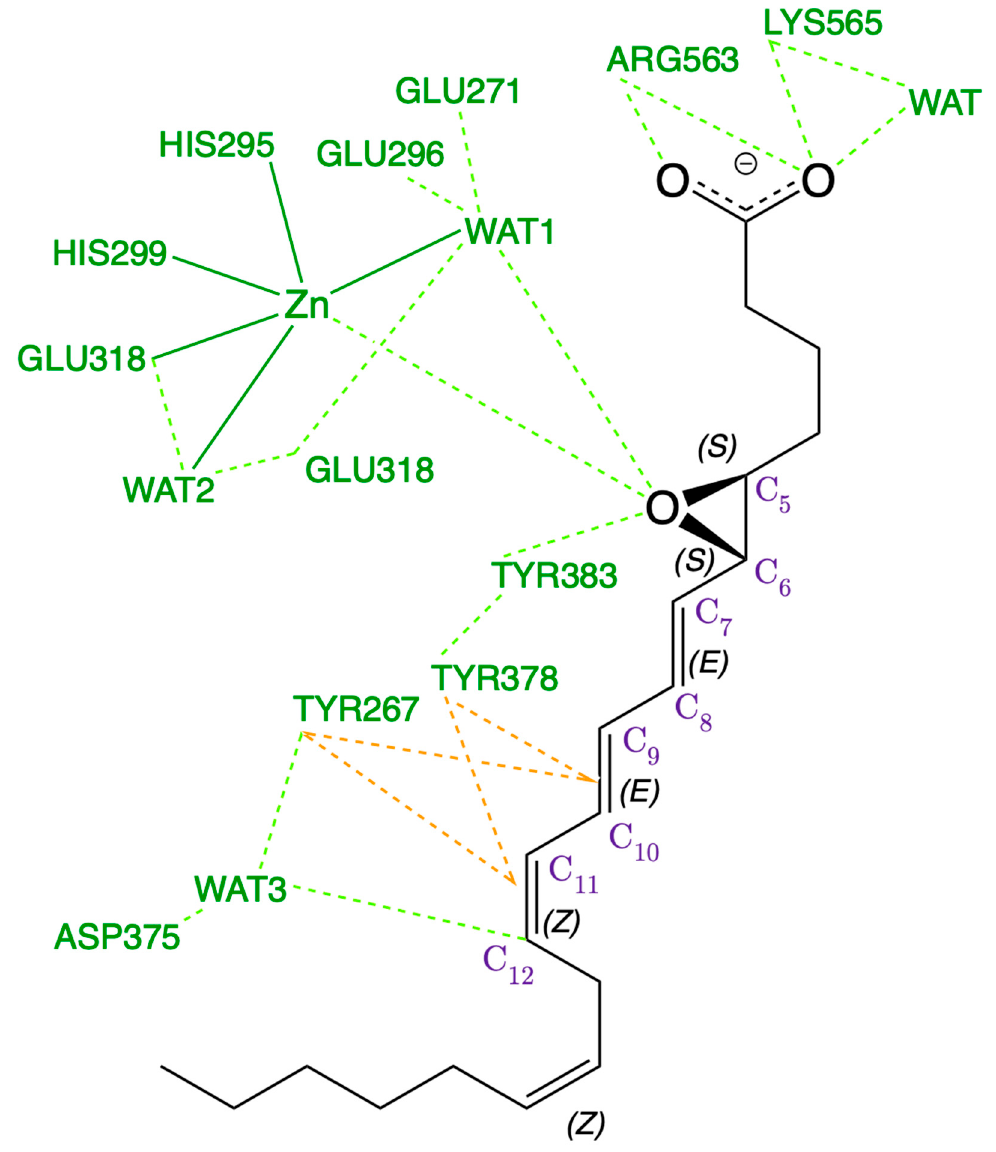
Figure 4. Scheme of the main noncovalent interactions (in dashed lines) between the substrate LTA 4 (in black) and the enzyme LTA 4 H (in green) in the optimised Michaelis complex and the Zn environment. The dashed orange lines indicate π - π stacking interactions.